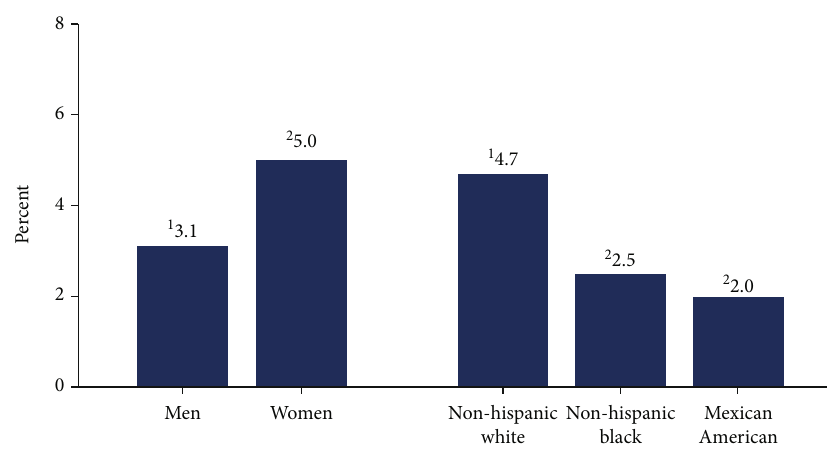
Figure 2: Proportion of basketball course selection of di ff erent